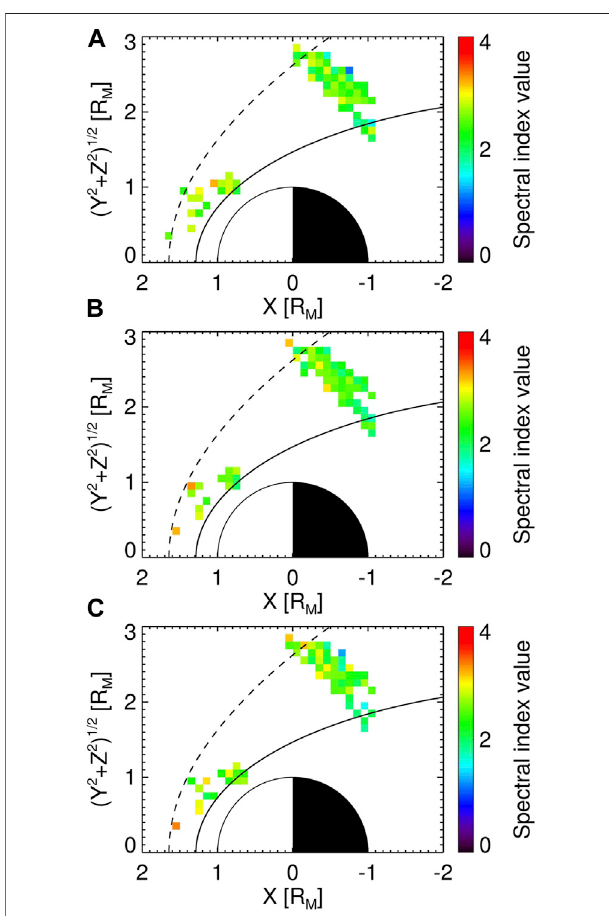
FIGURE 4 | Spectral index value distributions: (A) the median value of the spectral indices computed by 1-min data before each small-scale magnetic hole; (B) the median value of the spectral indices computed by 1- min datecontainingasmall-scalemagnetic hole; (C) the median valueof the spectral indices computed by 1-min date after each small-scale magnetic hole.